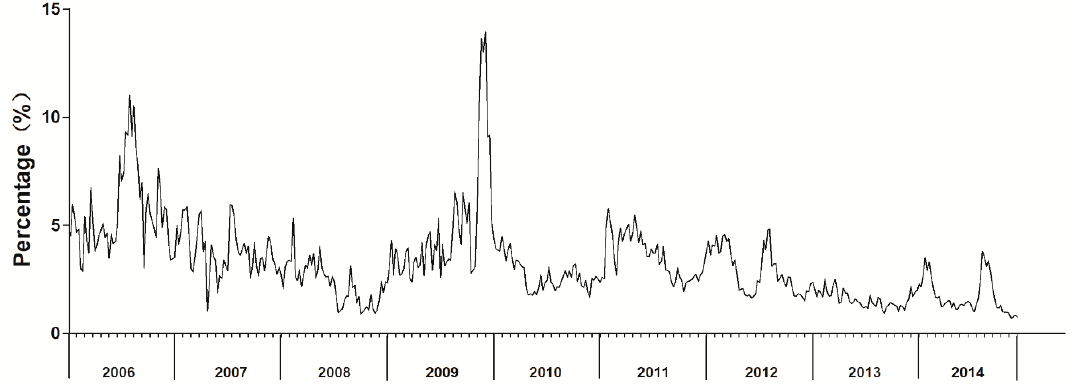
Figure 1. Monthly influenza-like illness rates in Ningbo, China, 2006–2014.